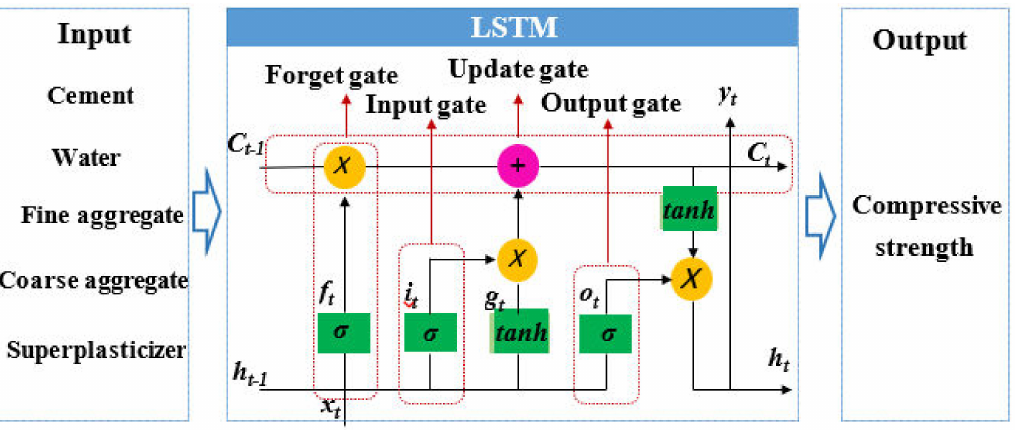
Figure 1. The structure of compressive strength prediction using